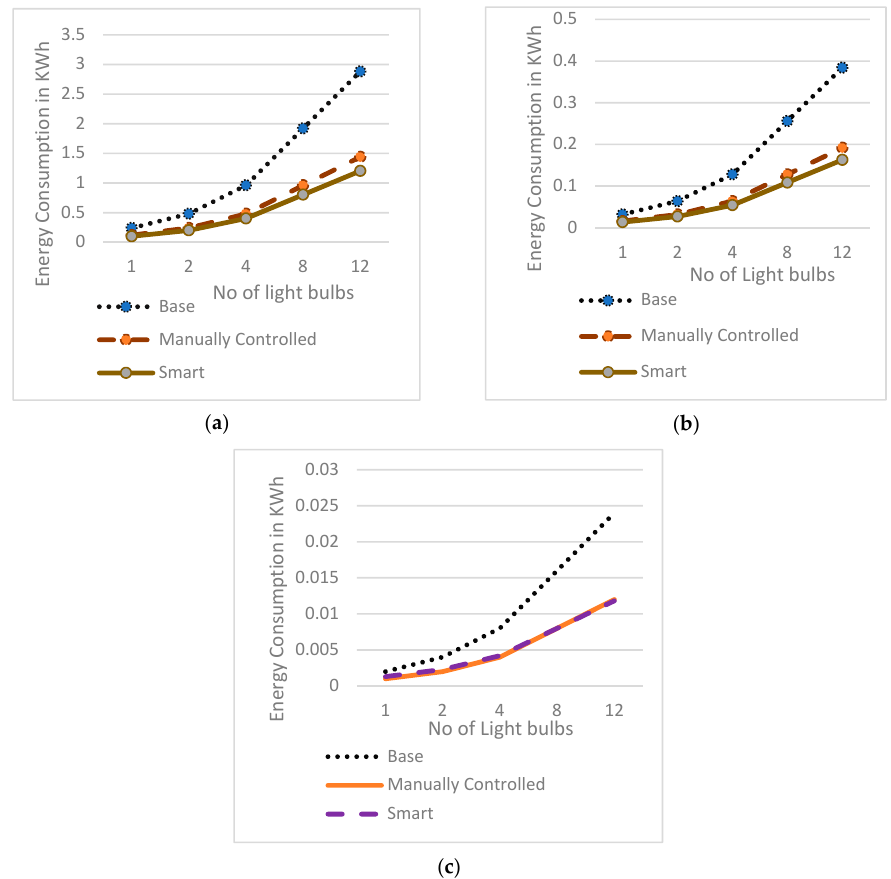
Figure 8. Energy Consumption in KWh vs. number of light bulbs for: ( a ) 60 W incandescent light bulbs in three scenarios, ( b ) 8 W LED light bulbs in three scenarios, ( c ) 0.5 W LED light bulbs in three scenarios.